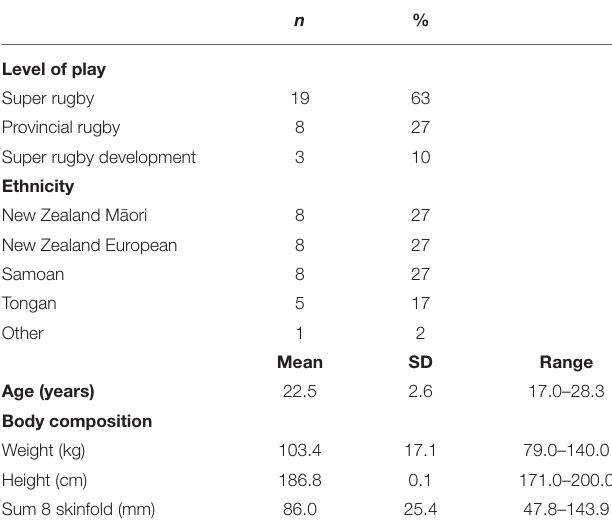
TABLE 1 | Demographic and body composition of